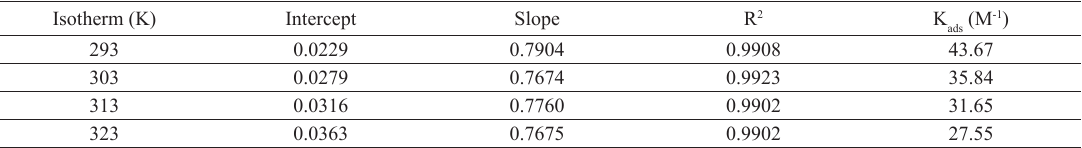
Table 3. Parameters for Langmuir adsorption of mild steel in 0.5 M HCl solution containing different concentrations of TTA (0.01 to 0.07 M) at various temperatures (293, 303, 313 and 323 K). Isotherm (K)